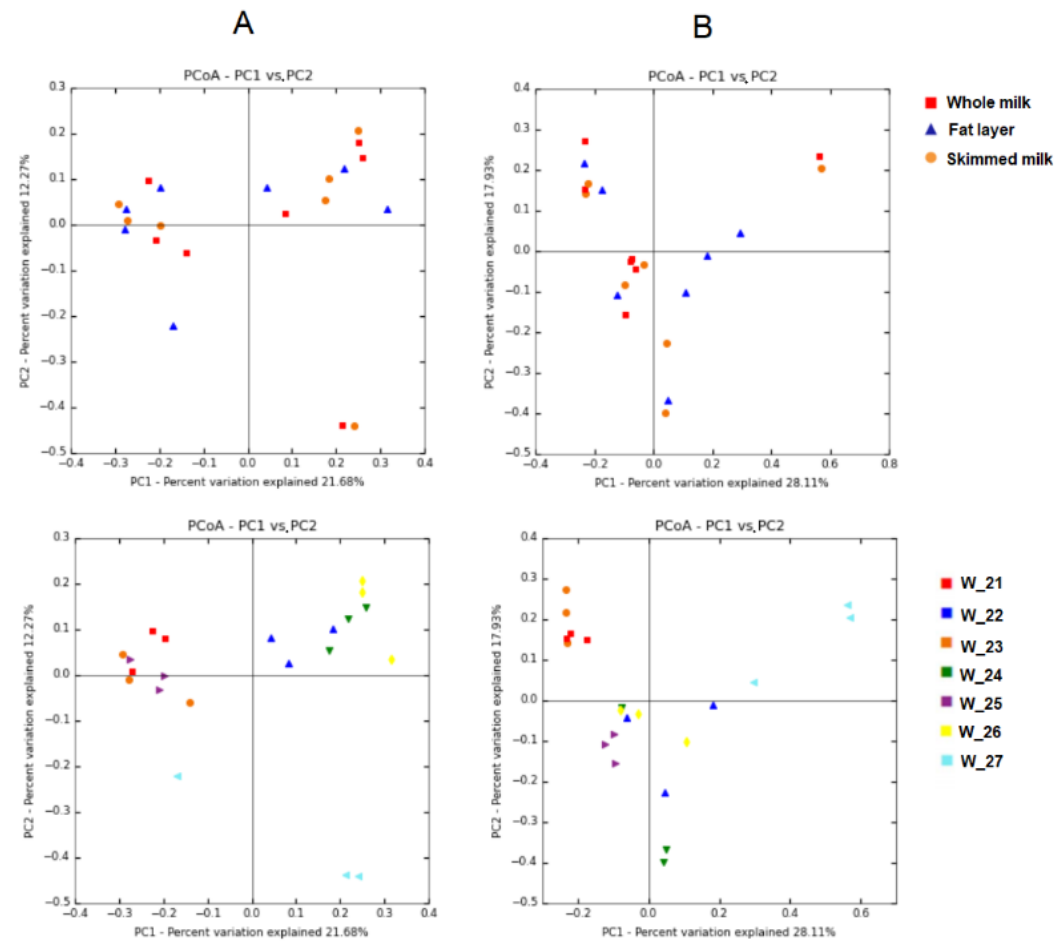
Figure 5. PCoA plots of bacterial profiles (at the OTU level) based on the Jaccard’s coefficient for binary data (presence/absence) ( A ) and on Bray–Curtis similarity analysis (relative abundance) ( B ) from the whole milk samples ( n = 7) collected from women 21 to 27 and their fractions: the fat layer and the skimmed milk. The value given on each axis label represents the percentage of the total variance explained by that axis. In the upper figures, color and shape of the symbol indicate the milk fraction (red squares, whole milk; blue triangles, fat layer; orange circles, skimmed milk). In the bottom figures, different colors of the symbols represent the samples provided by each woman, independently of the milk fraction.